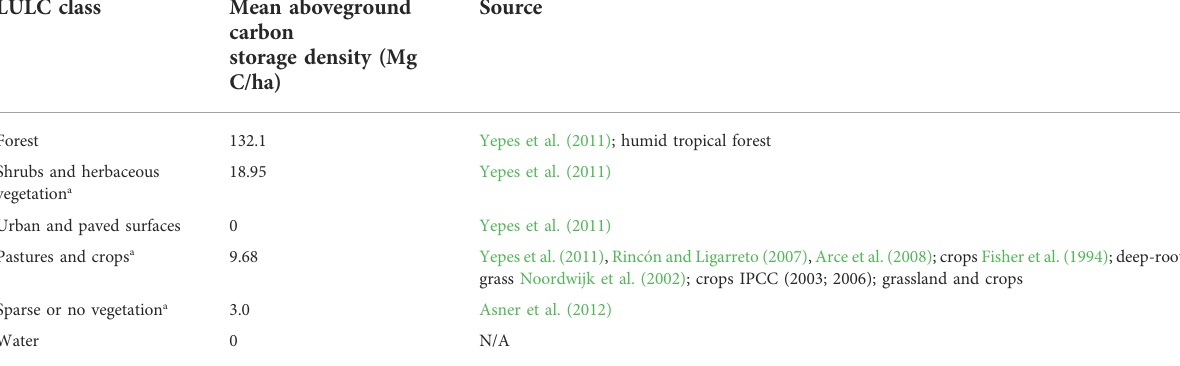
TABLE2Landuse-Land Cover(LULC)classes andreportedmeanabovegroundcarbonstoragedensities usedinthisstudy,withbibliographicsource. LULC